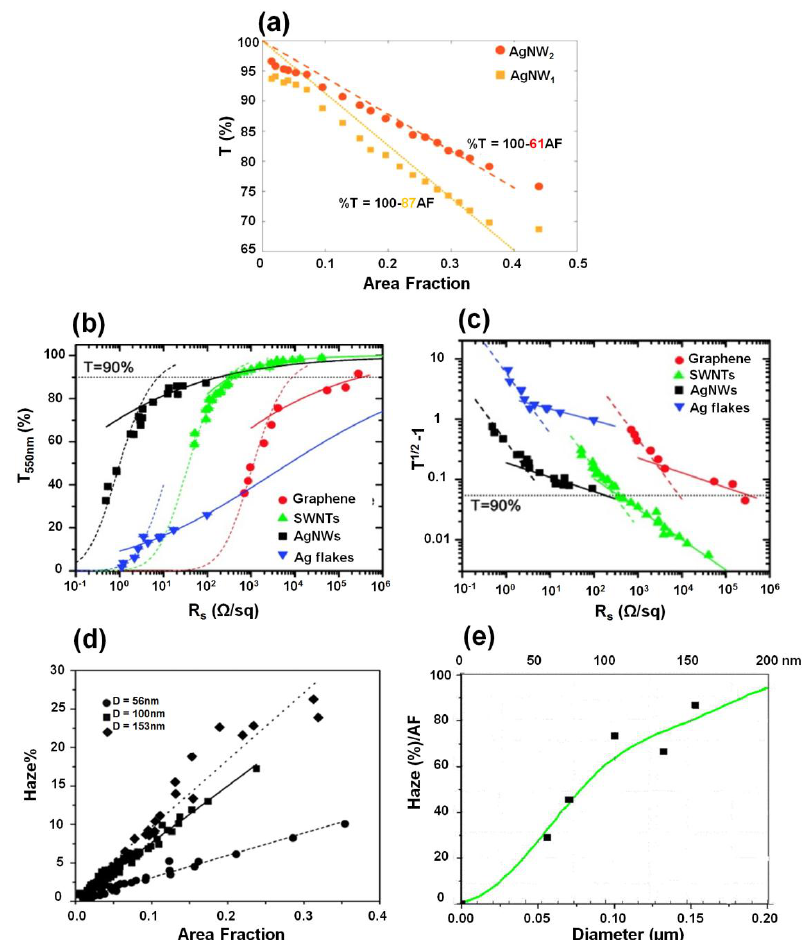
Figure 2. ( a ) The relationship between AF and transmittance ( T ). Different L/D in AgNW1 and AgNW2 lead to different trends in both T and R s . (Reproduced with permission from [43]. Copyright Springer Science + Business Media on behalf of the American Coatings Association and the Oil and Colour Chemist Association, 2015); ( b ) Transmittance (550 nm) plotted as a function of sheet resistance ( R s ) for thin films prepared from four nanostructured materials, graphene, single-walled carbon-based nanomaterials, Ag nanowires (NWs) and Ag flakes. The dashed lines represent fitted plots of the bulk regime using Equation (5), while the solid lines corresponds to the percolative regime using Equation (6); ( c ) The date in Figure 2a are re-plotted on the axes of ( T −1/2 − 1) and R s on log-log scale. Note that ( T −1/2 − 1) is proportional to film thickness. The dashed lines represent fitted plot of the bulk regime using Equation (5), while the solid lines corresponds to the percolative regime using Equation (6). (Reproduced with permission from [37]. Copyright American Chemical Society, 2010); ( d ) Haze factor (HF) vs. AF of Ag NWs with diameters of 56, 100, and 153 nm; ( e ) Slope of HF(%) vs. AF, HF(%)/AF, as a function of Ag NW diameter. (Reproduced with permission from [45]. Copyright AIP Publishing,